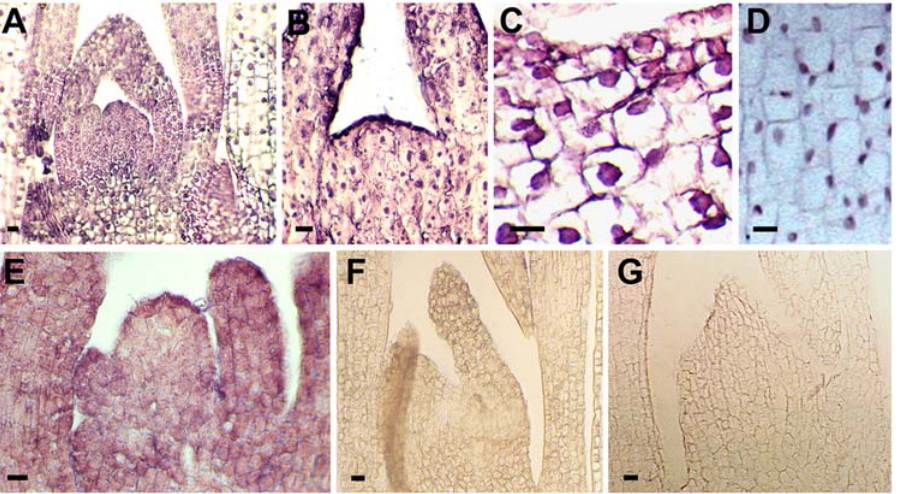
Figure 2. Immunocytochemical localization of VER2, showing labeling signals in shoot apex and young leaves. Sections were probed with anti-VER2 antibody followed by a goat anti-rabbit alkaline phosphatase (AP)-conjugated secondary antibody. (A) Plants were vernalized for 21 days. VER2 is predominantly targeted to potential nuclear structures. Weaker labeling was detected in cytoplasm. (B) An enlarged image showing labeling signals in shoot apical meristem. (C) An enlarged image showing labeling signals in young leaves. (D) Showing hematoxylin stained nuclei of young leaves. (E) Plants were first vernalized for 21 days, then devernalized. Signals were dispersed in the cytoplasm. (F) No immunocytochemical signal detected in nonvernalized plants. (G) Negative control performed by omitting the first antibody. Bars, 20 m